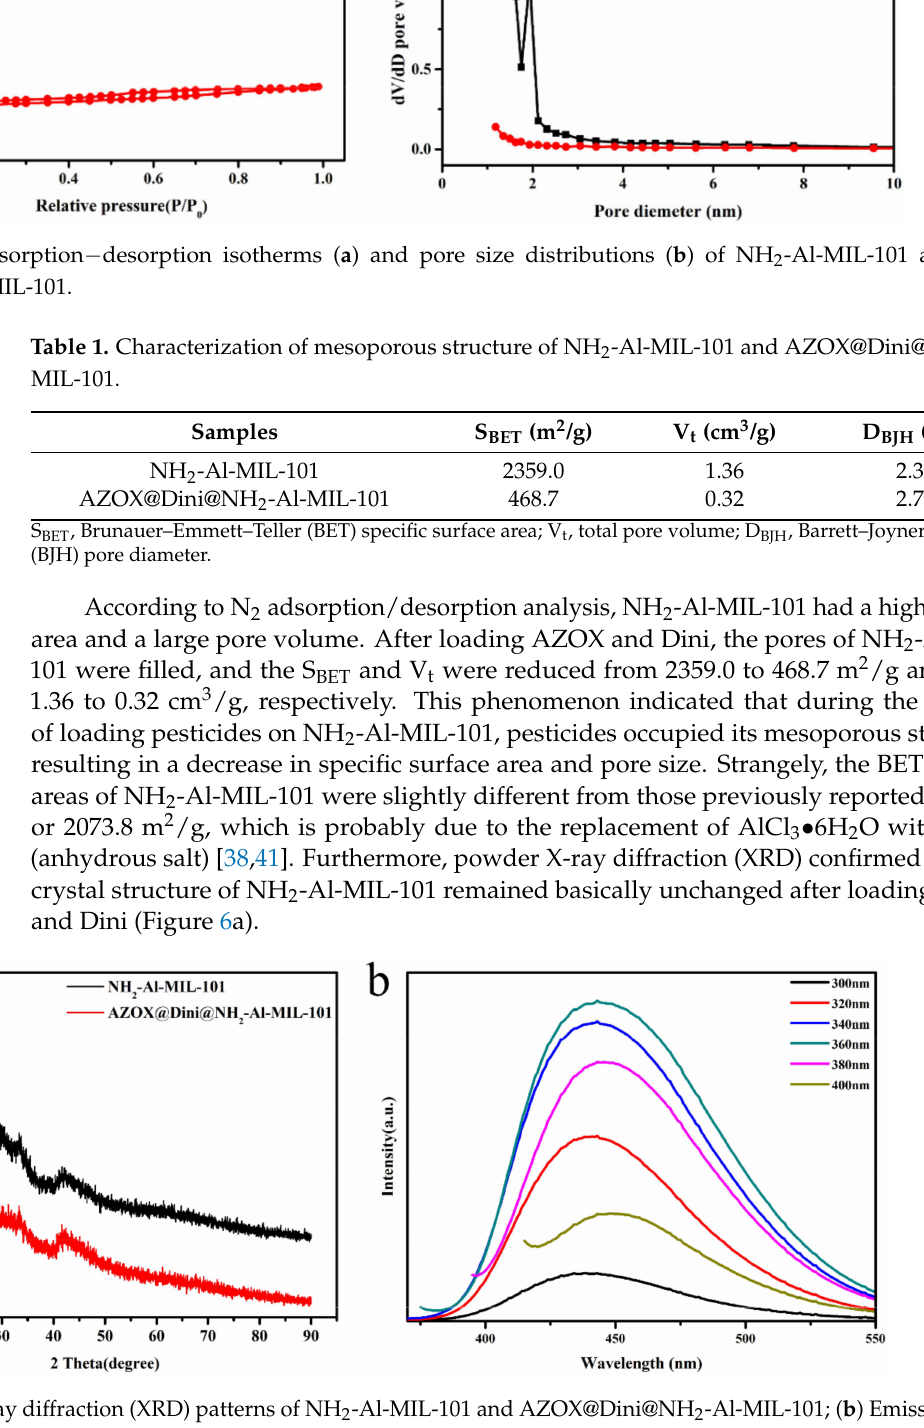
Figure 6. ( a ) Powder X-ray diffraction (XRD) patterns of NH 2 -Al-MIL-101 and AZOX@Dini@NH 2 -Al-MIL-101; ( b ) Emission spectra of NH 2 -Al-MIL-101 under different excitation